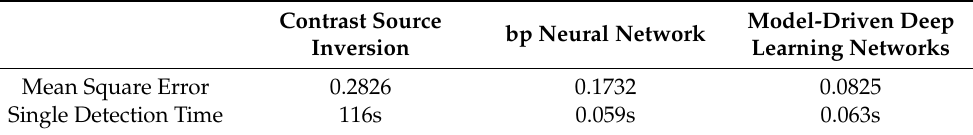
Figure 4. Concentric single defect model inversion imaging. ( a ) Concentric defect model with a radius of 2 cm. ( b ) CSI inversion results. ( c ) BP neural network inversion results. ( d ) Model ‐ driven deep learning network inversion results. Table 3. Mean square error and average single detection time for each